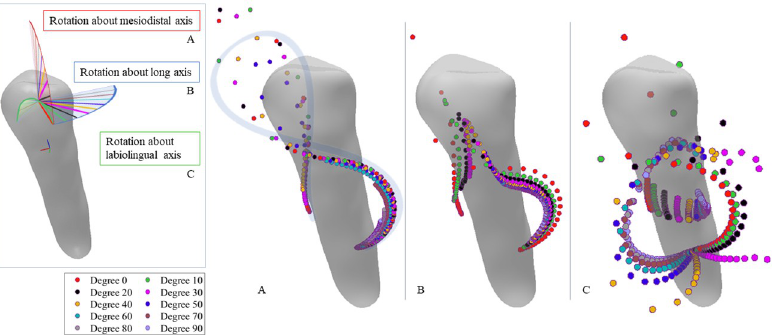
Fig 5. Effects of the couple’s directions on the CRots trajectories in scenario 2. Directions of the couple rotated about the tooth principal axes with various angles and the corresponding CRots for different couple magnitudes. Left: An illustration of how the couple forces are rotated about mesiodistal, long axis, and labiolingual of the tooth. Right(A to C): The corresponding CRots for the rotated couple about mesiodistal, long axis, and labiolingual of the left premolar of Patient 1 , respectively. Note that the initial direction of the couple and tipping load are set based on the surface normal direction.